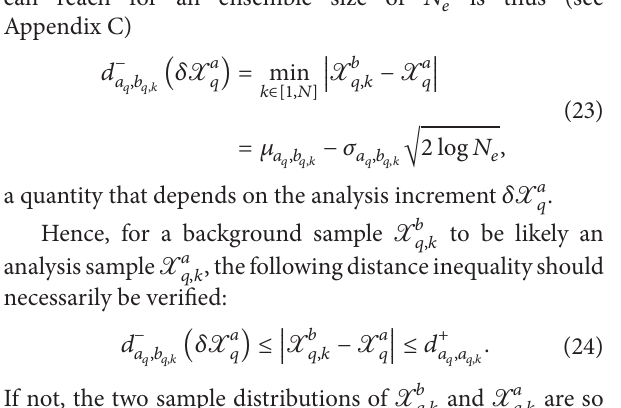
Figure 7: Histogram of distribution of the normalized distance (| X 𝑎 − X 𝑏 𝑘 | − 𝜇 𝑎,𝑏 due to the equivalence in the Gaussian setting), compared with the theoretical asymptotic Gaussian law N (0, 1) (solid line), estimated from an ensemble of 𝑁 = 6400 samples and represented for the different length-scale values: (a) 𝐿 𝑝 = 10 km, (b) 𝐿 𝑝 = 100 km, (c) 𝐿 𝑝 = 500 km, and (d) 𝐿 𝑝 = 1000 km, for the dimension set to 𝑛 = 1000